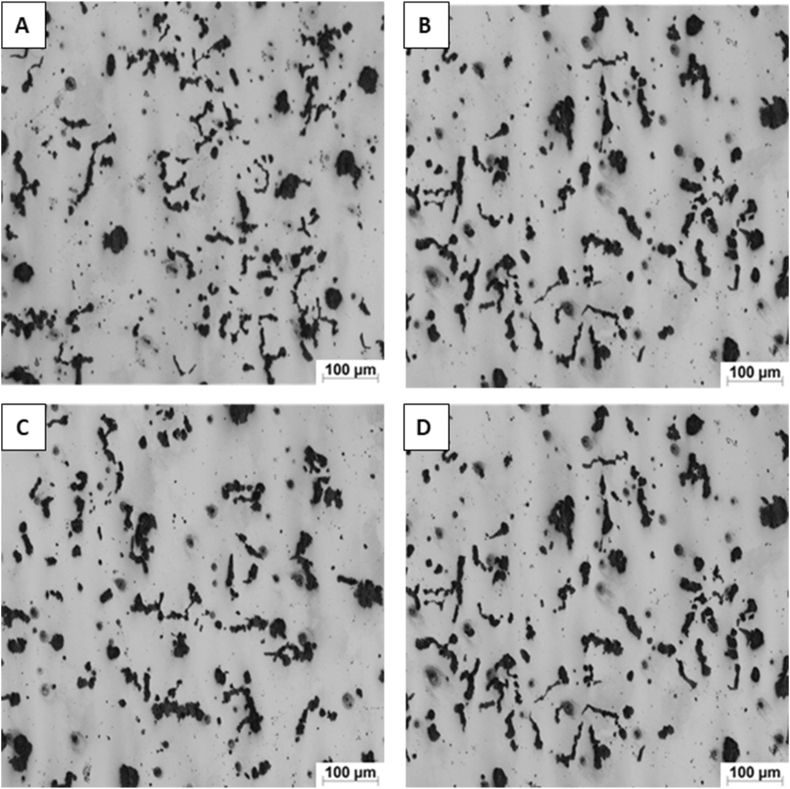
Nodularity % for sample number 2 with different thicknesses before etching: A) Wall thickness 5mm, nodularity % 23.10, B) Wall thickness 10mm, nodularity % 20.35,C) Wall thickness 15mm, nodularity % 17.78, and D) Wall thickness 20mm, nodularity % 13.65.